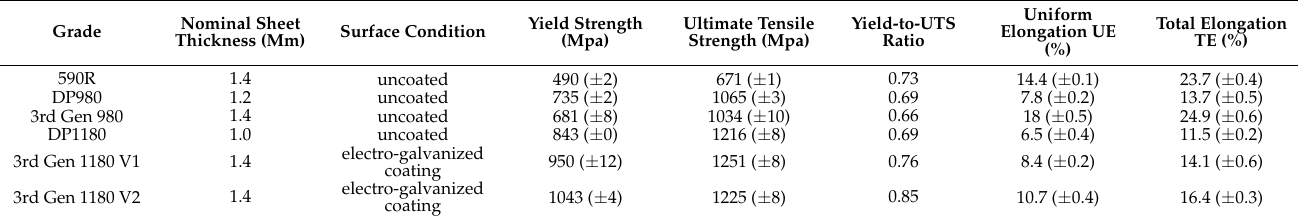
Figure 2. Engineering stress–strain response ( a ) and hardening rate obtained from the calibrated hardening model ( b ). Table 2. Mechanical properties obtained in quasi-static tensile tests in the TD. A 50 mm virtual extensometer was adopted for strain measurements and the uniform elongation was determined from the Considère Criterion.